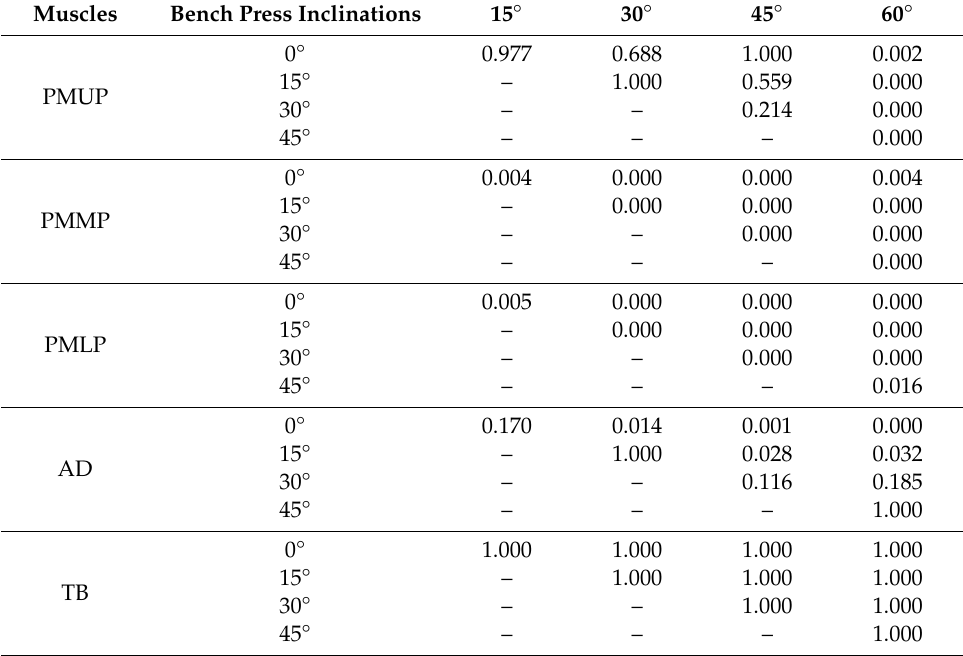
Table 2. Pairwise comparisons between the EMG activity (relative to % MVIC) of each muscle and the bench press